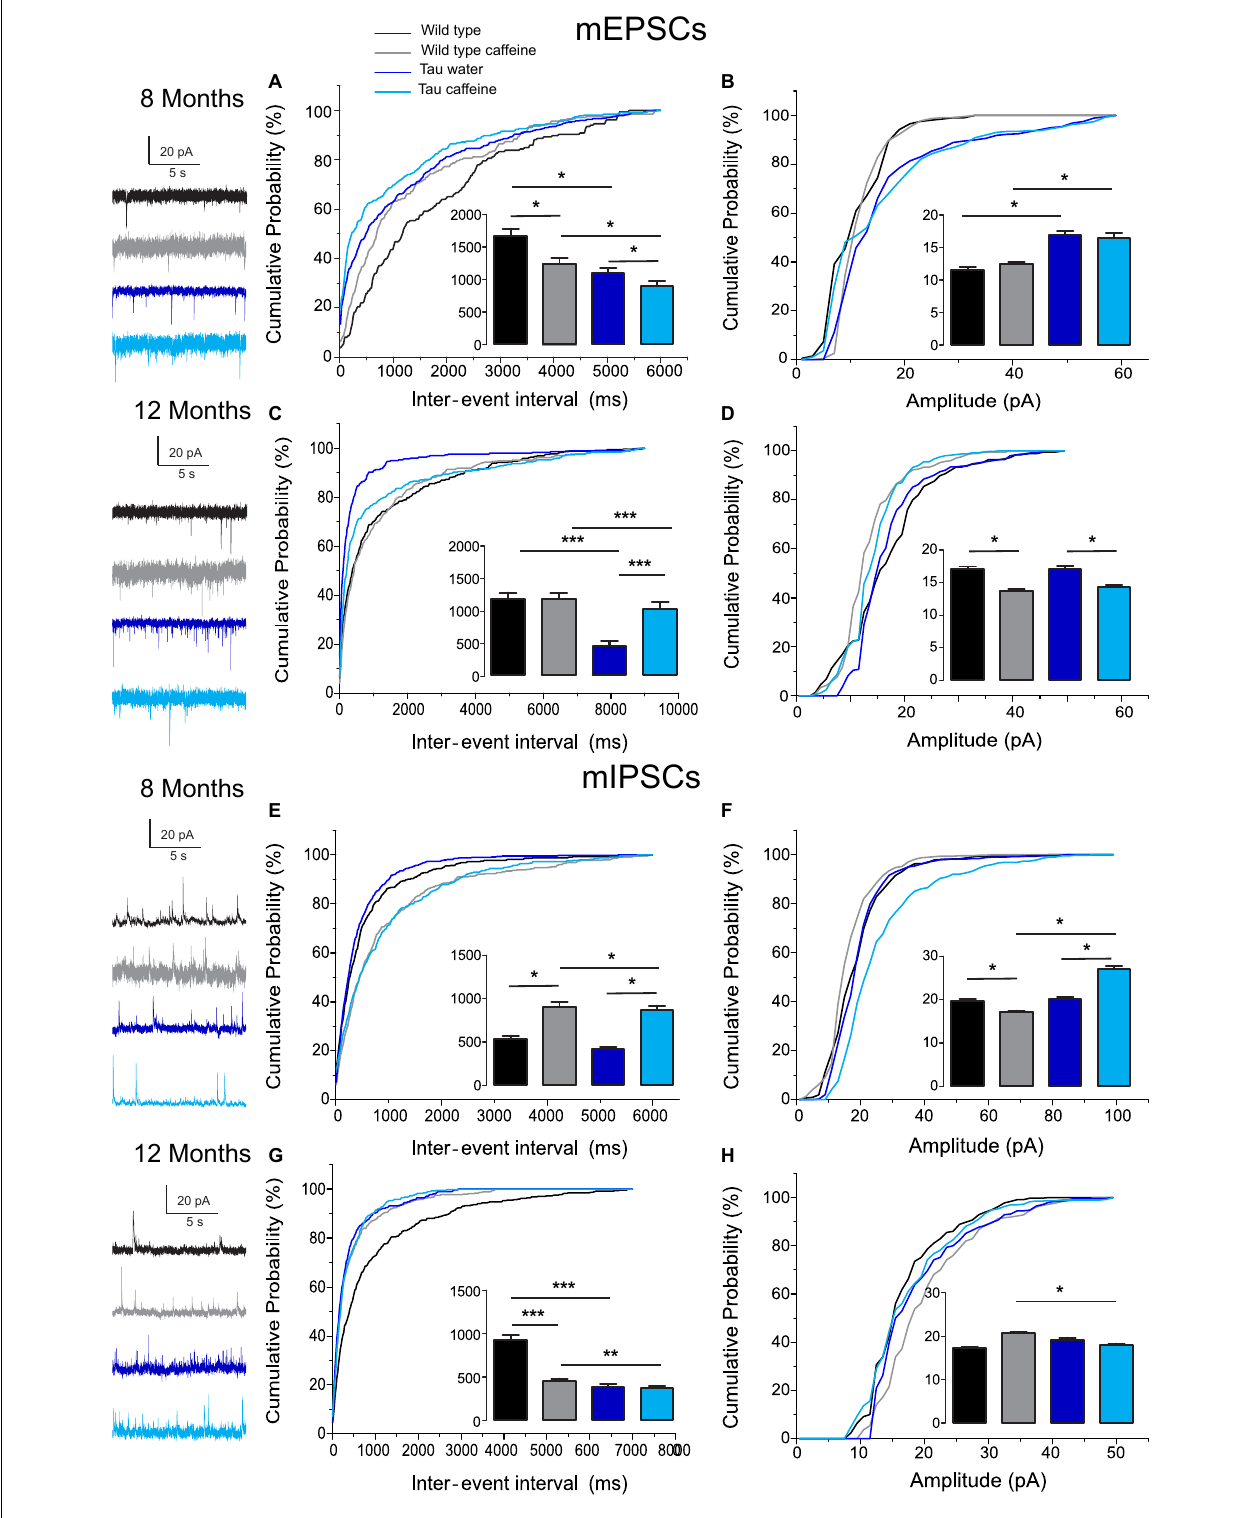
FIGURE 2 | Investigation of chronic caffeine exposure on miniature glutamatergic and GABAergic in vitro activities in 8 and 12 month-old Wild type and Tau mice. Representative traces of mEPSCs and mIPSCs recorded in CA1 hippocampal pyramidal cells of Wild type water (black), Wild type caffeine-treated (gray), Tau water (blue), and Tau caffeine-treated (light blue) mice are depicted on the left of the cumulative probability histograms [8 month-old mEPSCs: (A,B) ; 12 month-old